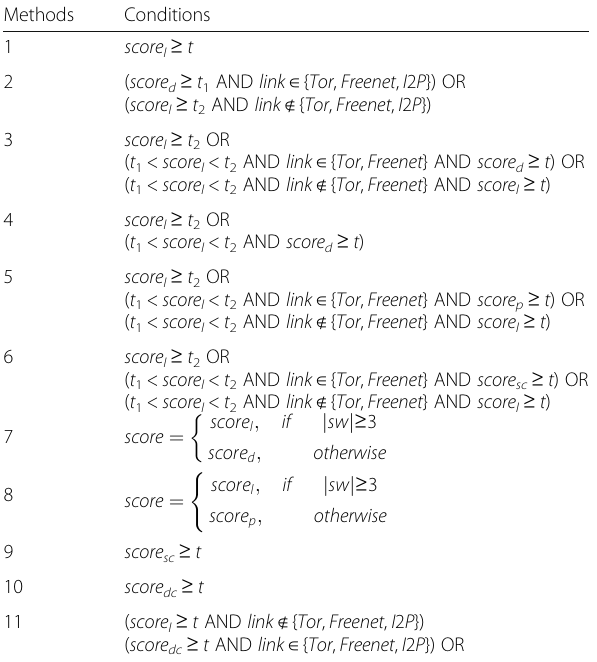
Table 2 Conditions under which each one of the 11 methods proposed